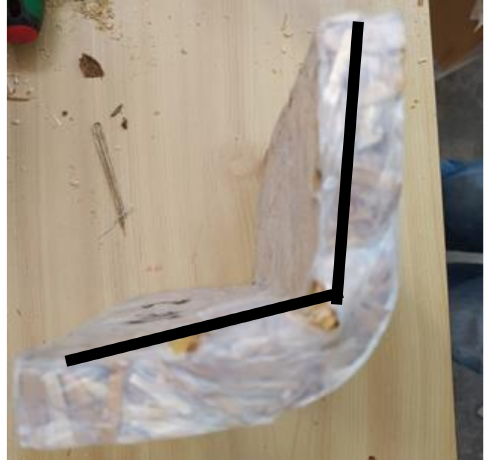
Figure 11. Bending results with preheating conditions and central